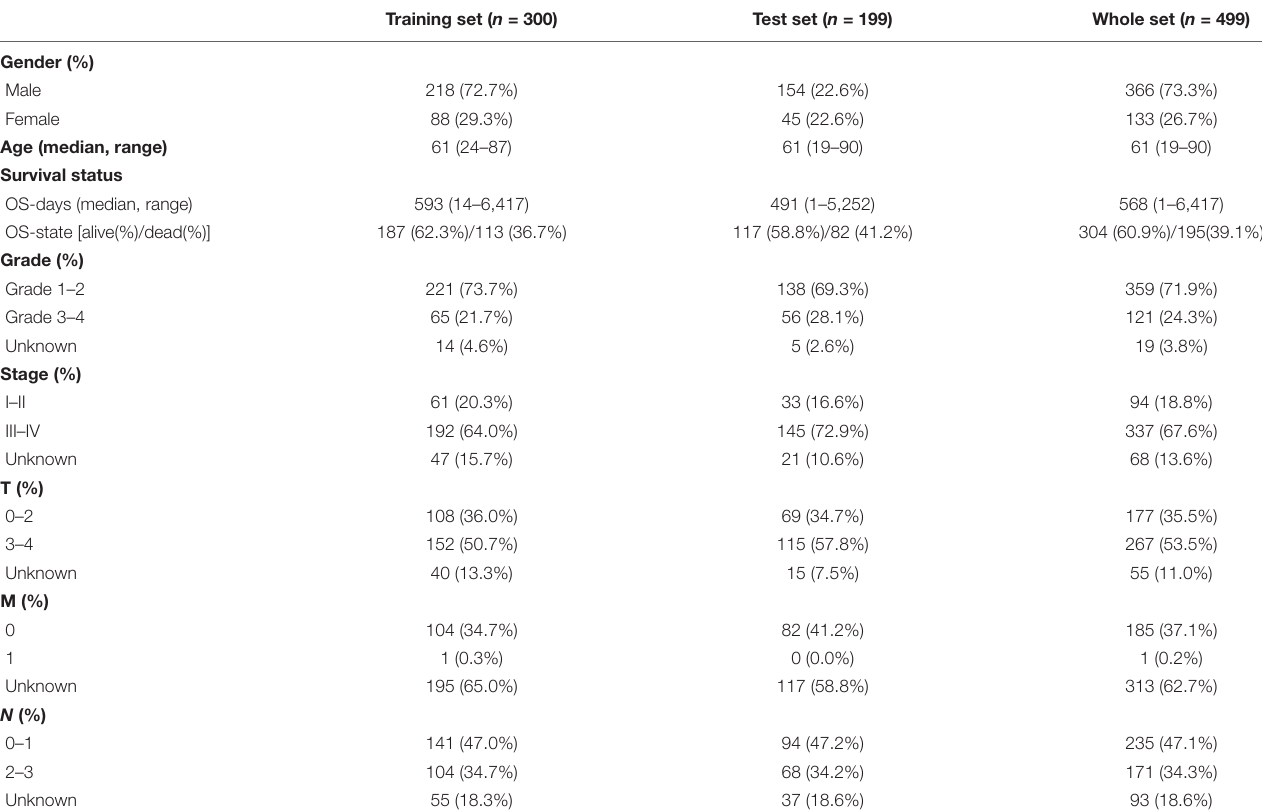
TABLE 1 | Clinical characteristics of the HNSCC samples in training, test, and whole sets. Training set ( n =